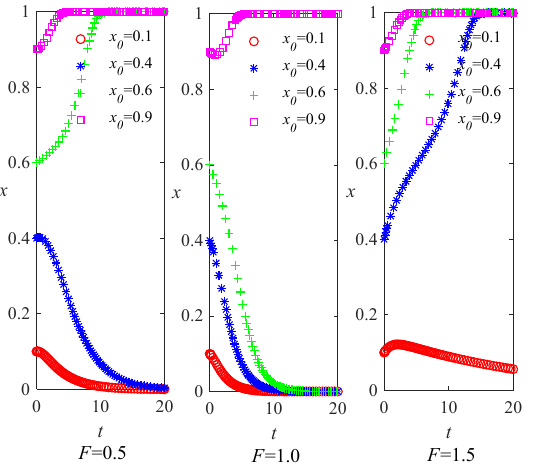
Figure 12. The impact of government punishment on construction enterprises on system evolution